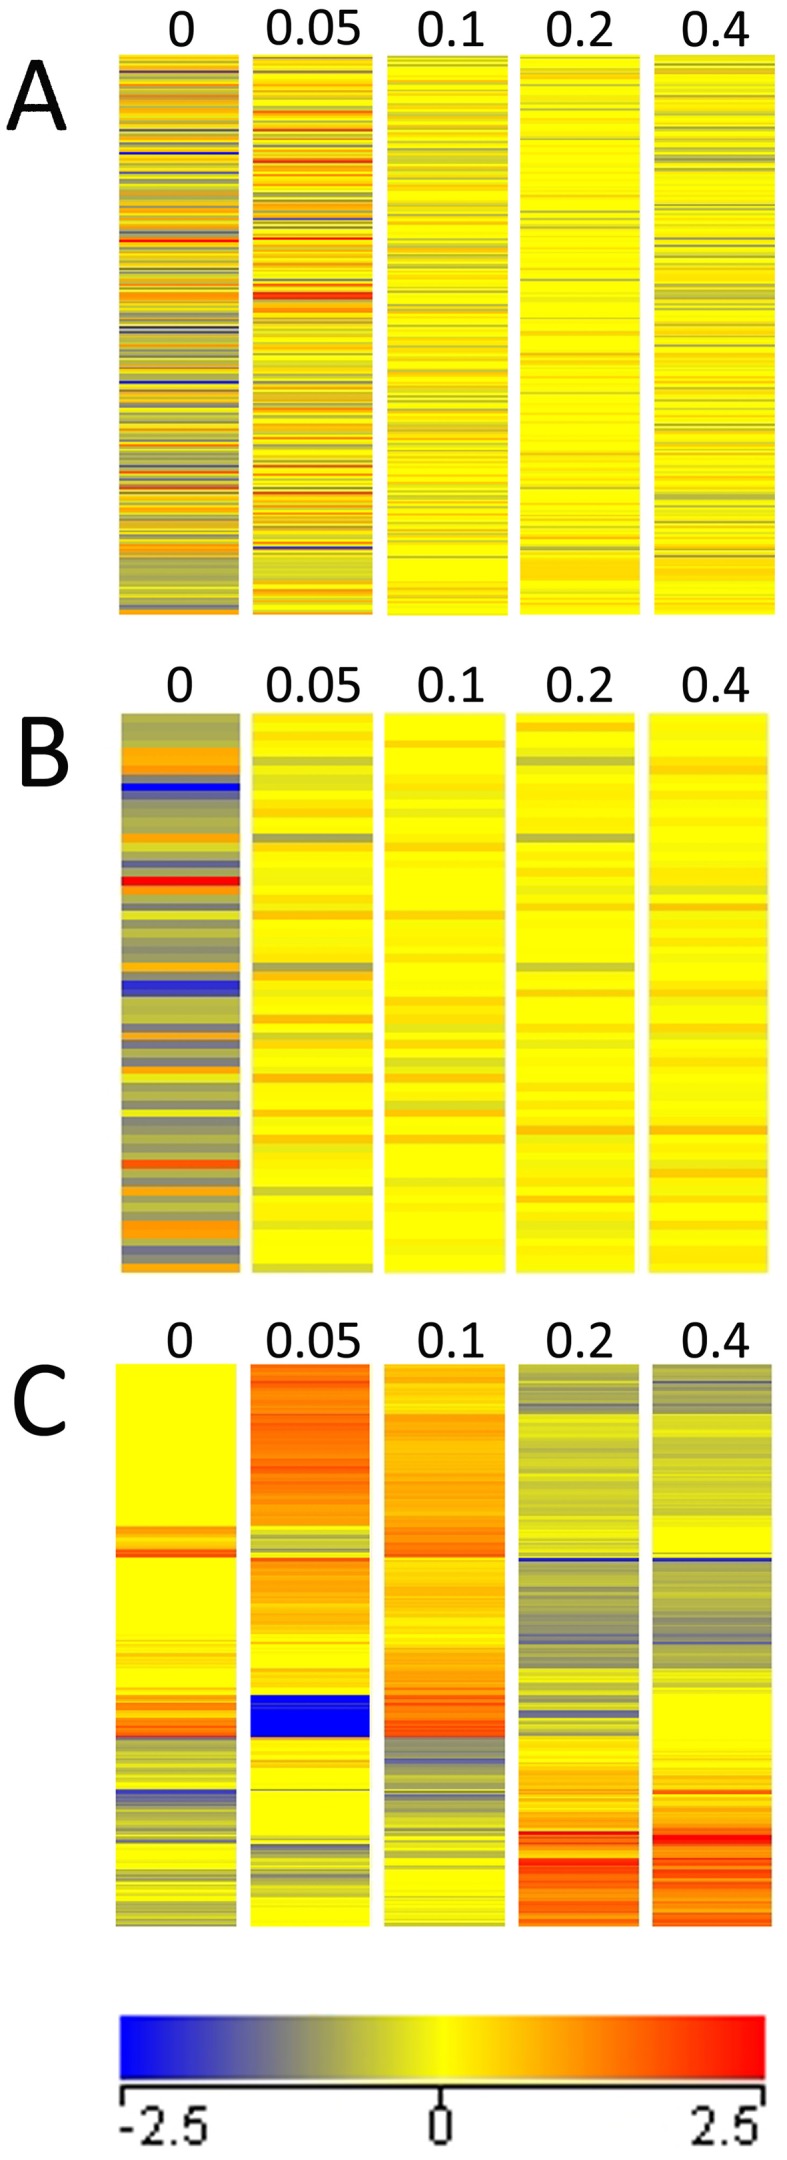
Hierarchical clustering of toxic-Se specific and low-Se specific datasets.Unsupervised hierarchical clustering of (A) 182 toxic-Se specific genes; (B) 247 low-Se transcripts; (C) 59 low-Se specific genes. Columns represent expression at 0, 0.05, 0.1, 0.2, and 0.4 mM Se. Gene expression is shown using a pseudocolor scale from −2.5 (blue) to +2.5 (red).